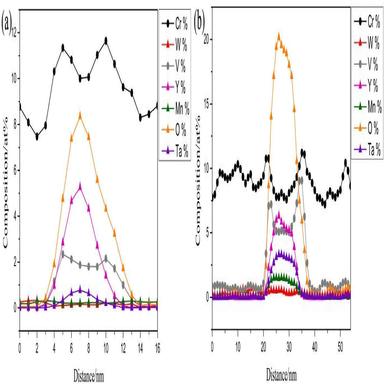
Composition profiles along the direction of analysis, intercepting a representative particle in (a) ODS Eurofer and (b) ODS Eurofer–2V–1.2Ta.